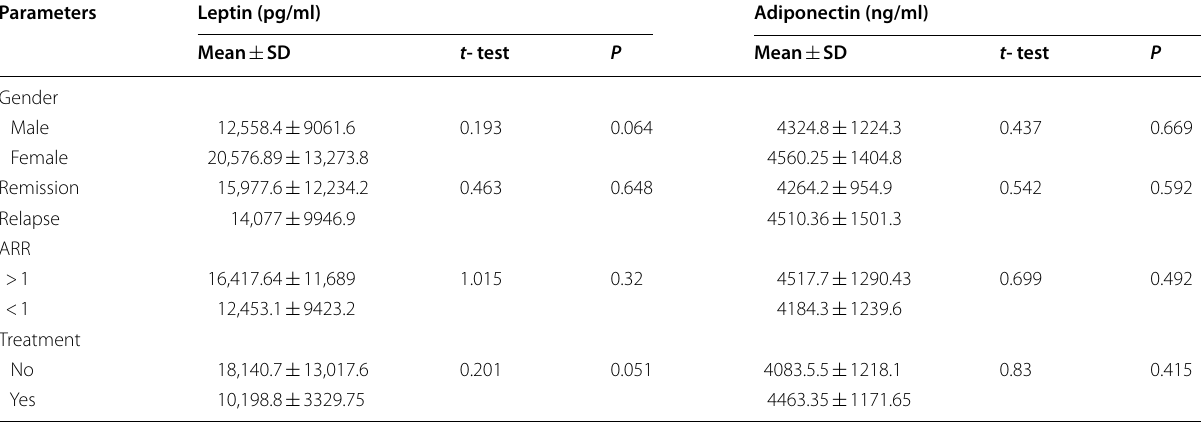
Table 3 Difference between serum leptin and adiponectin levels with regard to parameters